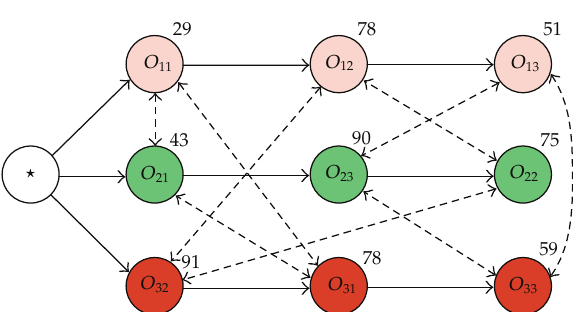
Figure 3: The disjunctive graph of the example instance.